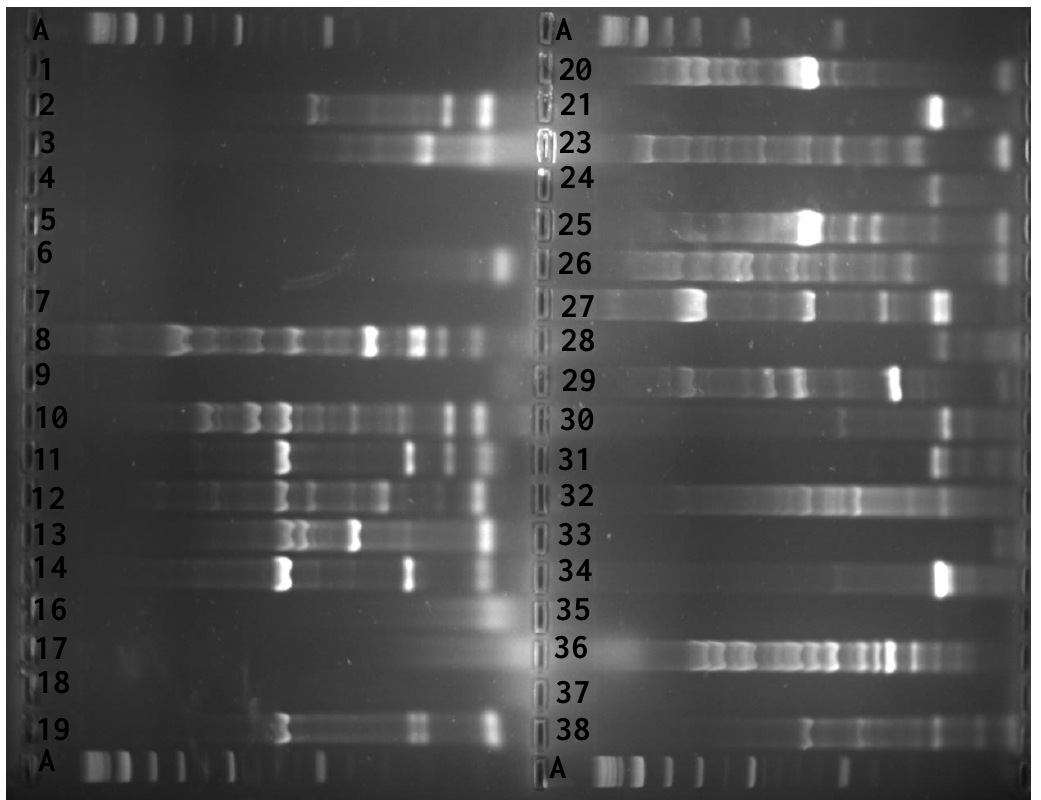
Figure 3. A representative ERIC-PCR fingerprint gel image.